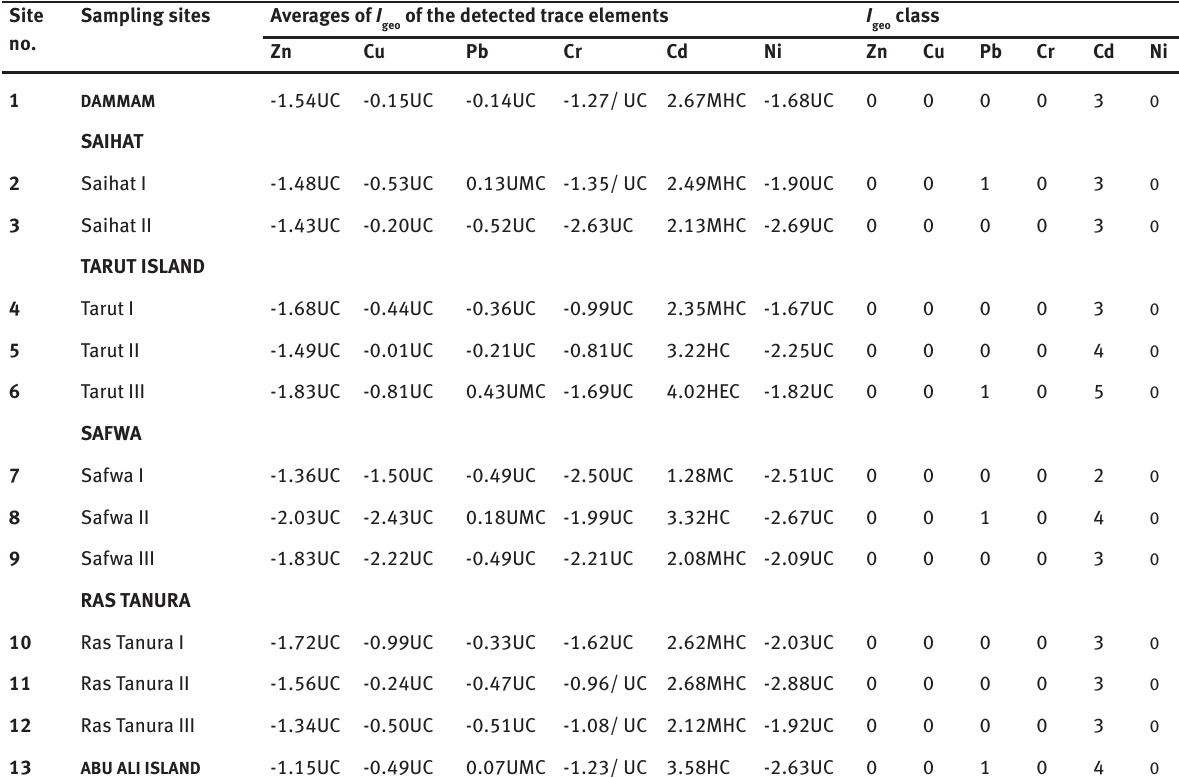
) of the studied trace elements at studied sites. geo